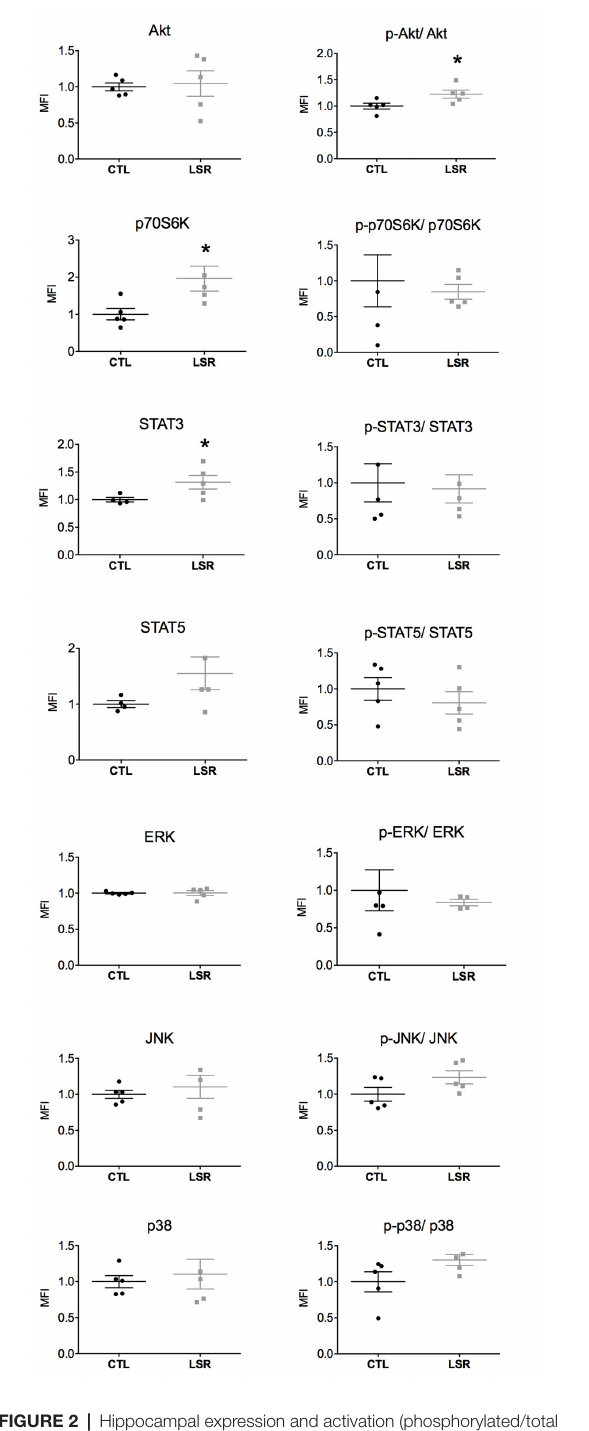
FIGURE 2 | Hippocampal expression and activation (phosphorylated/total protein) of intracellular signaling pathways in rats from the laser (LSR) and control (CTL) groups. Data are presented as individual points to show dispersion and as mean and standard error of the mean ( ± SEM). Significant increases in the expression of p70S6K and STAT3 and Akt activation were found in the laser group when compared to the control group (*). Data were normalized to the mean fluorescence intensity (MFI) of the control group ( p < 0.05; Mann-Whitney